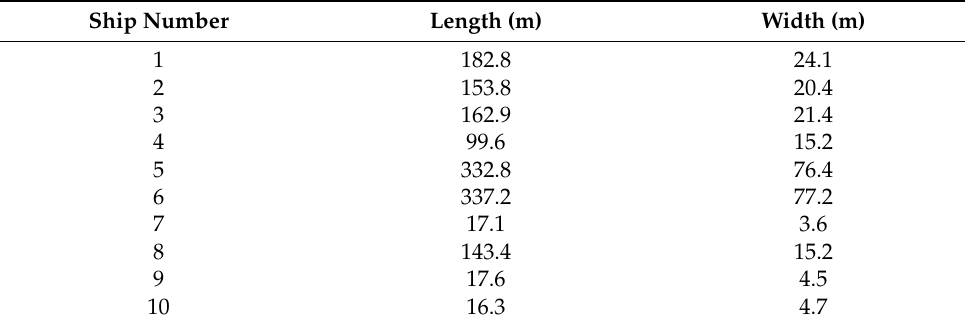
Table 1. Structural parameters of ten types of ship